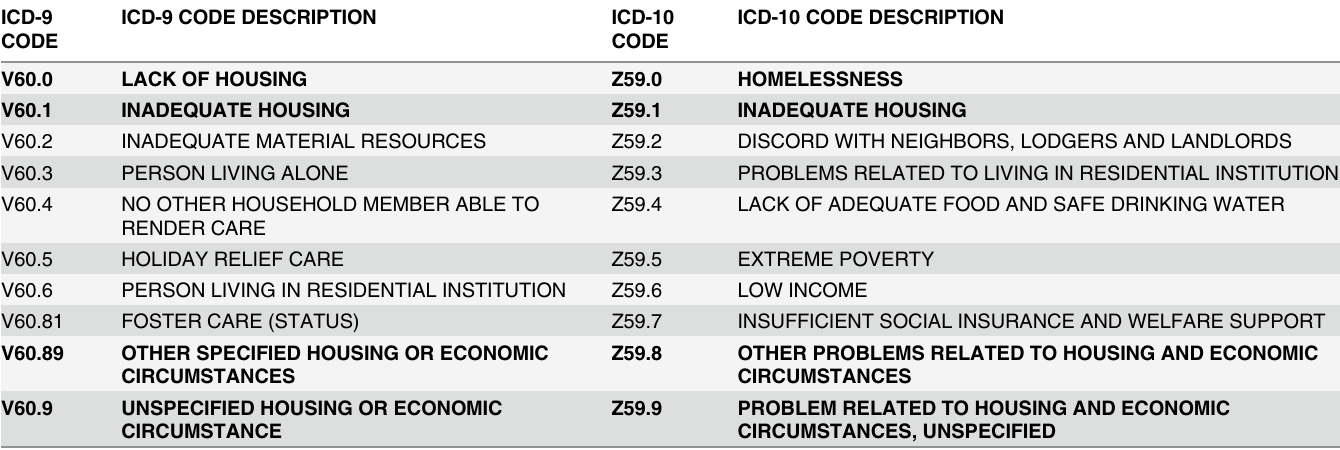
Table 1. Comparison of V60 series ICD-9-CM codes and Z59 series ICD-10-codes from the Centers for Medicare & Medicaid Services. From http:// www.cms.gov/medicare-coverage-database/staticpages/icd-9-code-lookup.aspx?KeyWord = v60&bc=AAAAAAAAAAAQAA%3d%3d&; Accessed